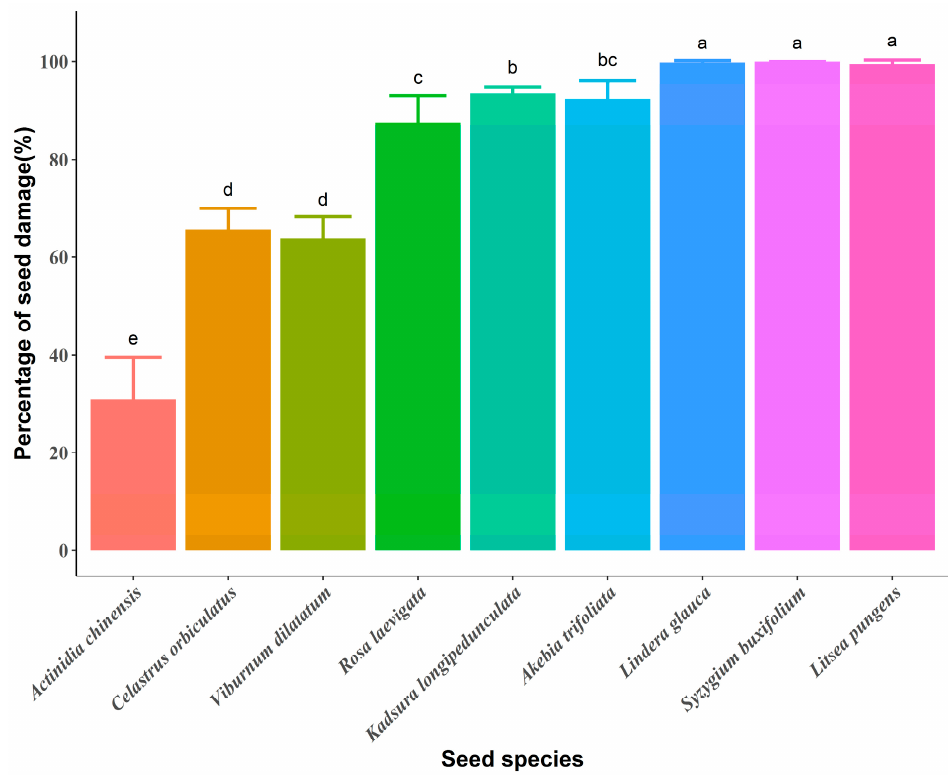
Figure 1. Percentage (mean % ± SD) of the destruction of nine seed species ingested through captive Tibetan macaques ( Macaca thibetana ) and the differences in the percentage of seed destruction ( PSD ) between seed species. The seeds are arranged according to MCD from smallest to largest. Different letters indicate significant differences ( p < 0.05) among groups.